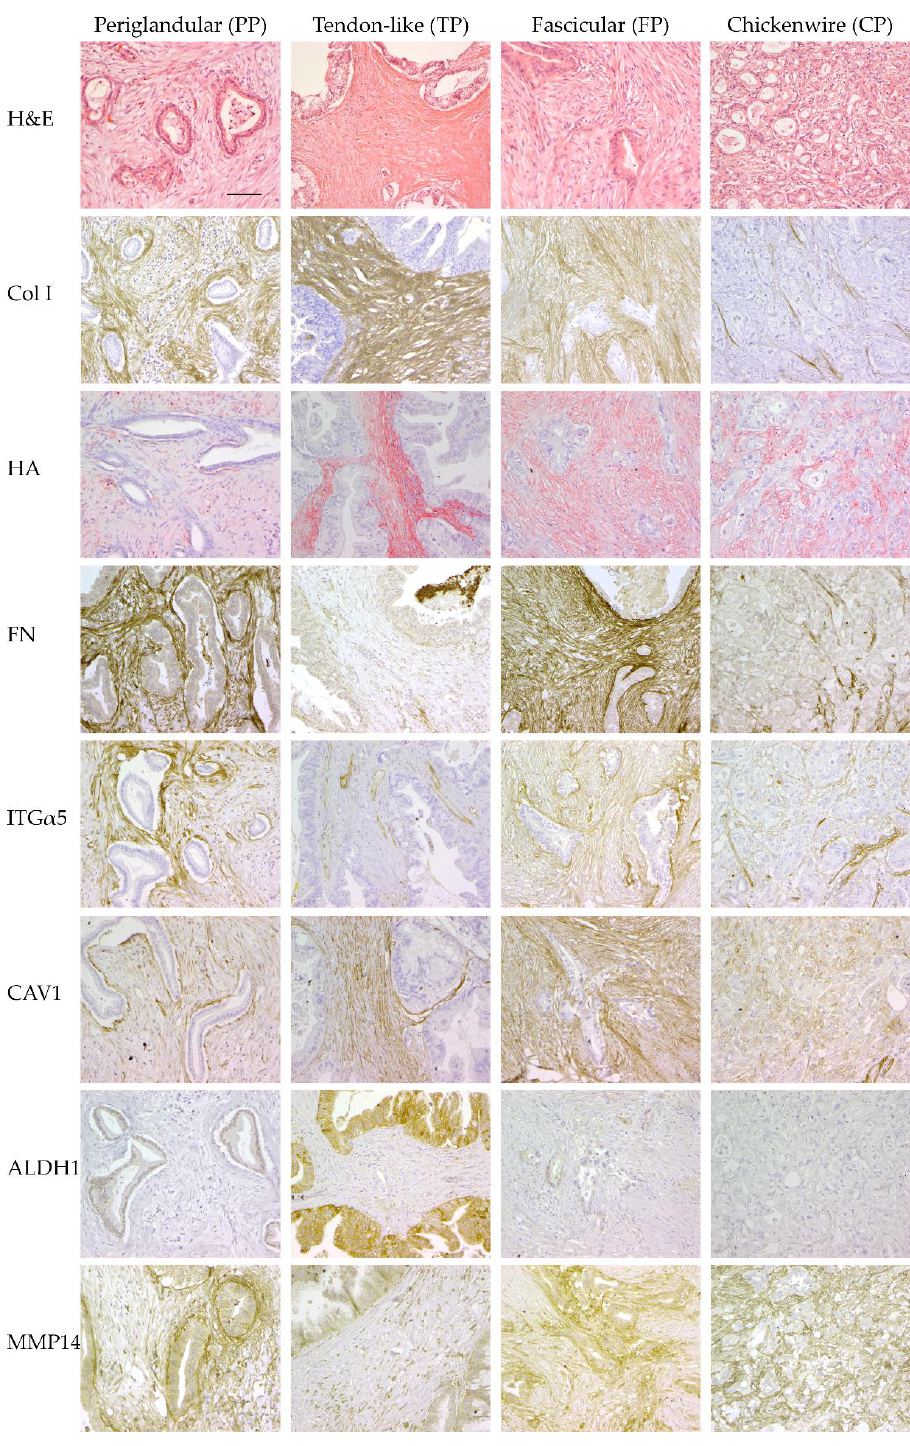
Figure 3. Divergence of stromal and cancer cell-related features in the four pancreatic cancer patterns. Representative microphotographs of hematoxylin and eosin (H&E) staining and (immuno-)histochemistry for selected features (200x; scale bar = 100 μm) are shown. ALDH1, aldehyde dehydrogenase 1; CAV1, caveolin-1; Col I, collagen I; HA, hyaluronan; H&E, hematoxylin and eosin; FN, fibronectin; ITGα5, integrinα5; MMP14, matrix metalloproteinase 14.